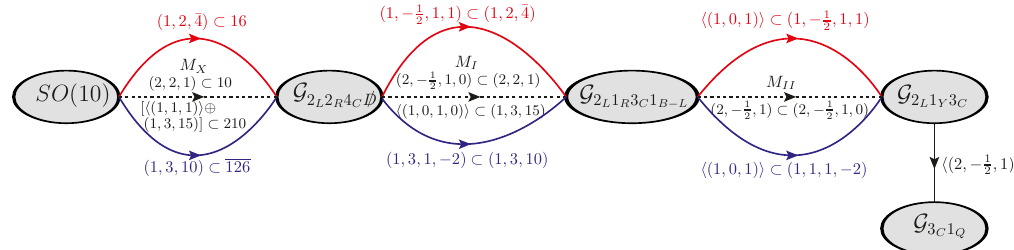
Figure 1. SO(10) breaking to the SM via two intermediate steps. The VEVs causing the successive symmetry breakings and the Higgs fields contributing to the RGEs at each stage are indicated. The upper (red) arrows correspond to the model in section 3.1, and the lower (blue) arrows correspond to the model in section 3.2. The dashed arrows in the middle are common to both